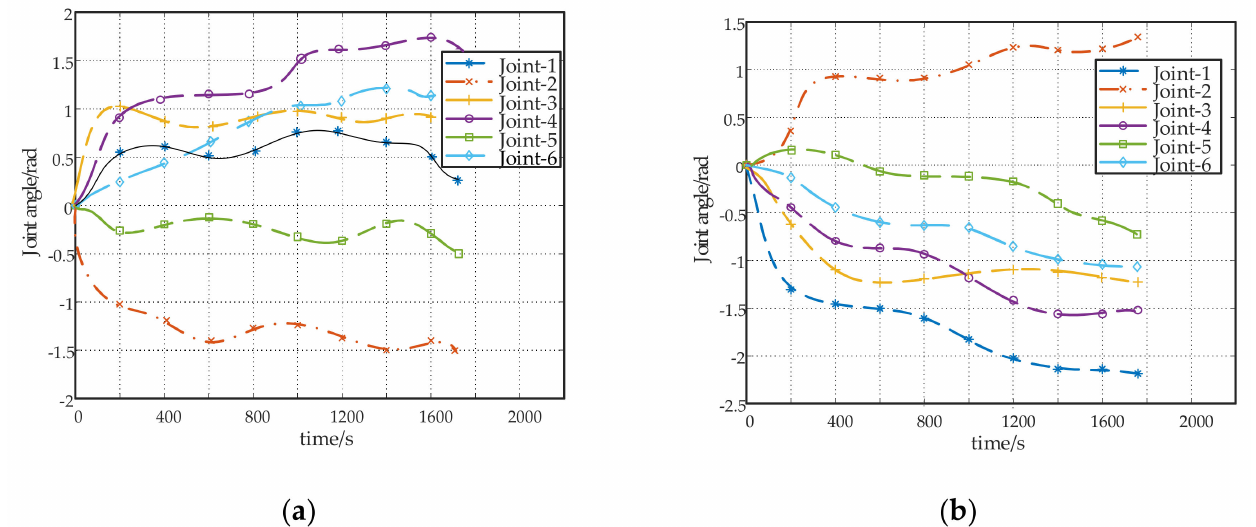
Figure 10. Results of obstacle avoidance with T-APF. ( a ) Variation of each joint angle of the left arm of the robot during collision avoidance; ( b ) variation of each joint angle of the right arm of the robot during collision avoidance.